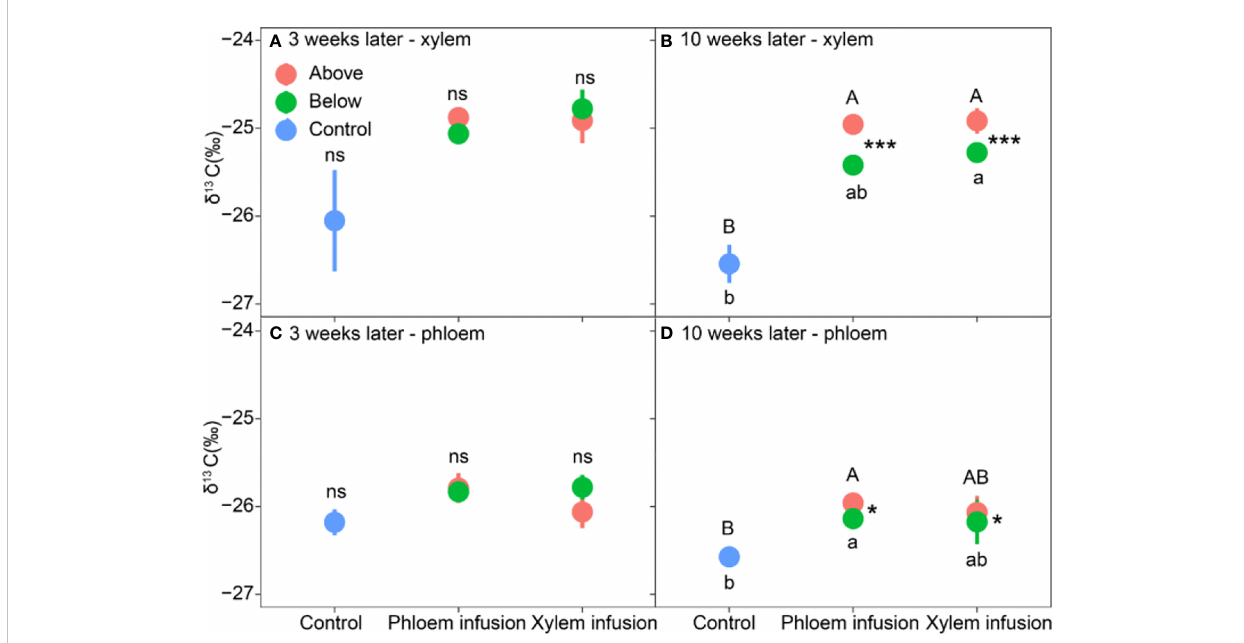
FIGURE 4 Effects of 13 C-labelled glucose infusion into phloem and xylem tissues of adult Pinus sylvestris trees compared to controls (n = 3, mean value ± 1 SE). Tissues were collected from positions above (red color) and below (green) the infusion point at the time of three weeks ( A, C ; leaf panel) and ten weeks ( B, D ; right panel) after the infusion started. Note different capital letters indicate signi fi cant differences in d 13 C values among ‘ above ’ - samples and controls, and different lowercase letters indicate signi fi cant differences in d 13 C values among ‘ below ’ -samples and controls. * (P < 0.05) and *** (P < 0.001) denote signi fi cant differences in d 13 C values between ‘ above ’ and ‘ below ’ -samples within a